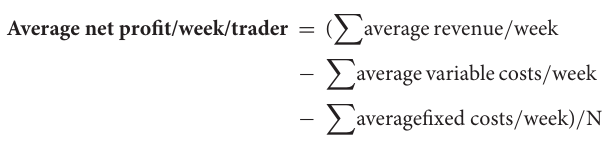
TABLE 1 | Total number of traders and sampled number for semi-structured interviews.